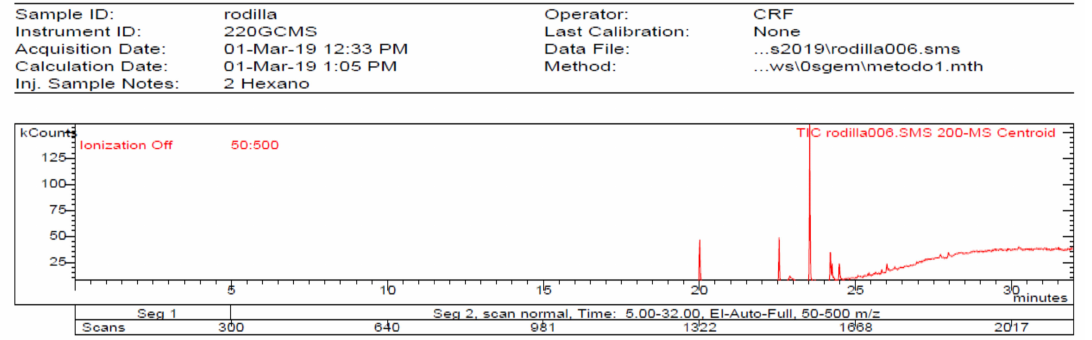
Figure 3. Chromatogram of Hexane extract part soluble in MeOH esterified whit diazomethane, 2-Hexane